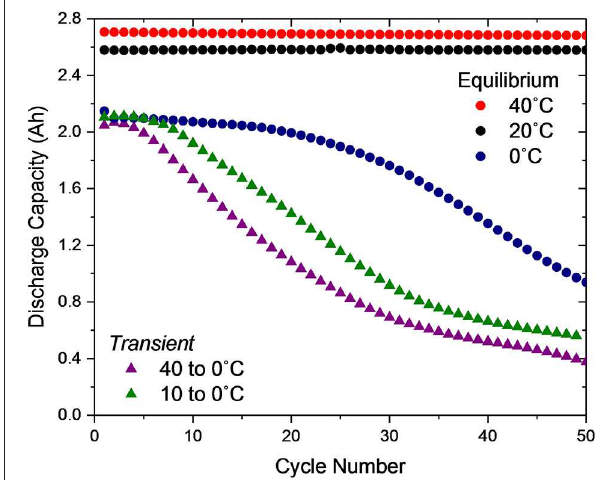
FIGURE 4 | Discharge capacity over 50 cycles for all five cell